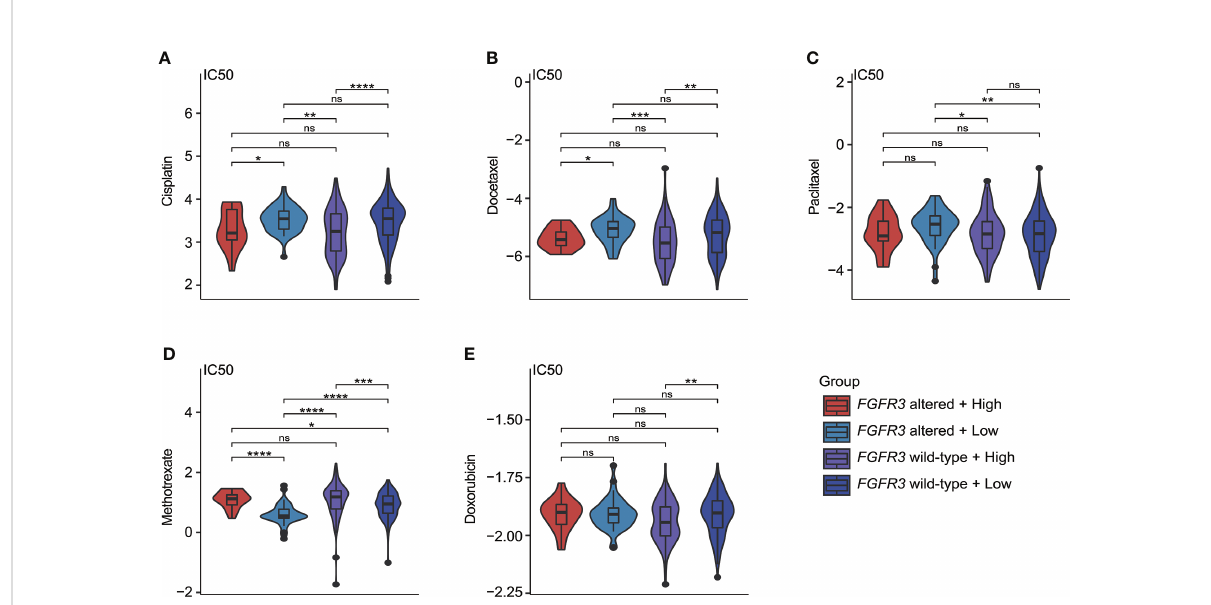
FIGURE 11 The estimate of chemotherapy treatment response via the GDSC database. The violin plots exhibited the IC 50 value representing the response of chemotherapeutic treatment by cisplatin (A) , docetaxel (B) , paclitaxel (C) , methotrexate (D) , and doxorubicin (E) between four different